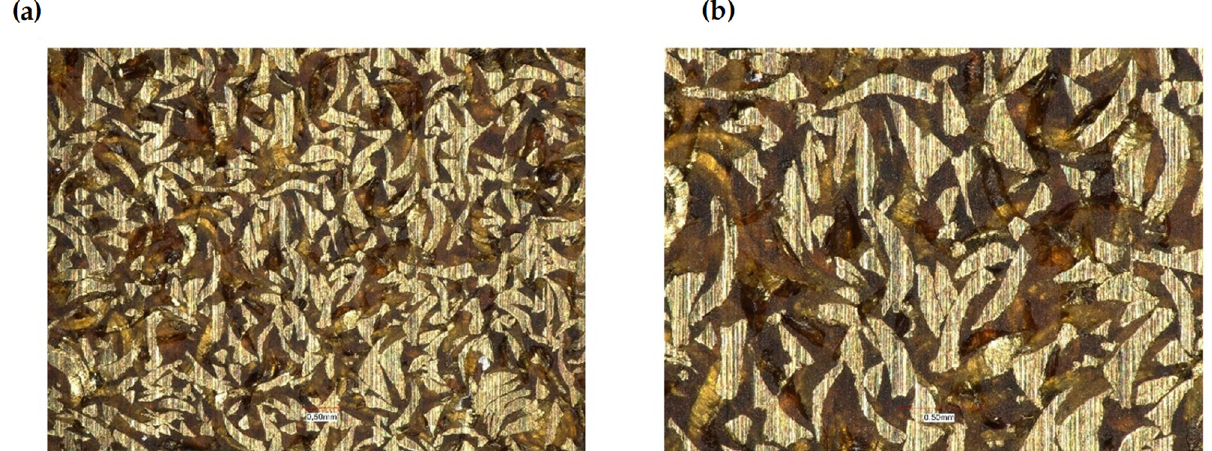
Figure 10. Composite of acrylic–phenolic resin with brass chips: ( a ) magnification 50×, ( b ) magnifi- cation 100×.